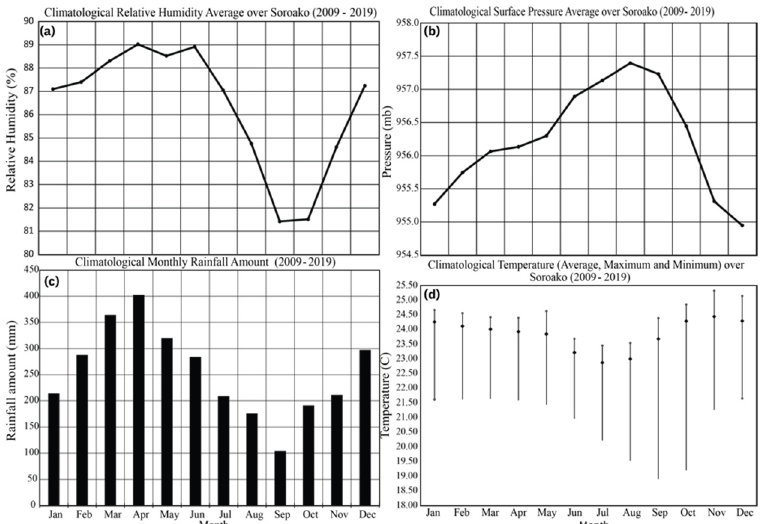
Figure 4. ( a ) Climatological conditions of RH; ( b ) surface pressure; ( c ) monthly rainfall amount; and ( d ) surface temperature over Sorowako (Larona Basin). The climatological period was calculated from 2009 to 2019. Monthly rainfall amount was derived from rain-gauge measurements, whereas RH, surface pressure, and temperature were derived from ERA5 reanalysis data.